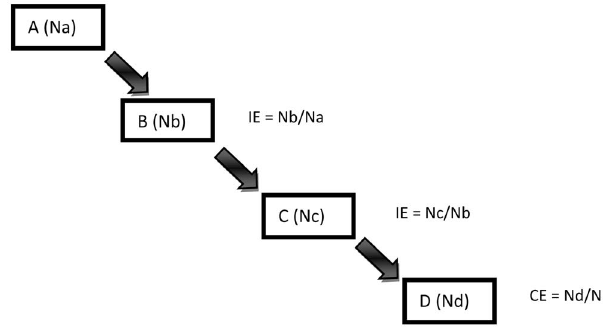
Figure 2. Formula for calculating intermediate and cumulative systems effectiveness. Where: N=Total number of target popula- tion; Nx=Number of women successfully completing step x IE: Intermediate effectiveness; CE: Cumulative